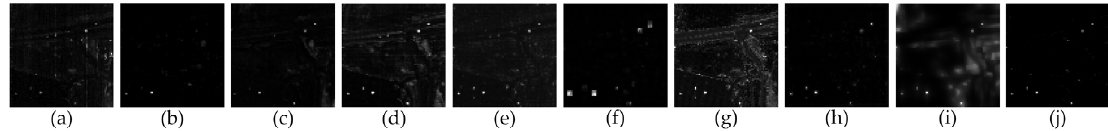
Figure 9. The detection results of different methods on the urban dataset: ( a ) RX; ( b ) LRX; ( c ) LSMAD; ( d ) LSDM–MoG; ( e ) CDASC; ( f ) 2S–GLRT; ( g ) BFAD; ( h ) SSFSCRD; ( i ) AED; ( j ) SCDF.